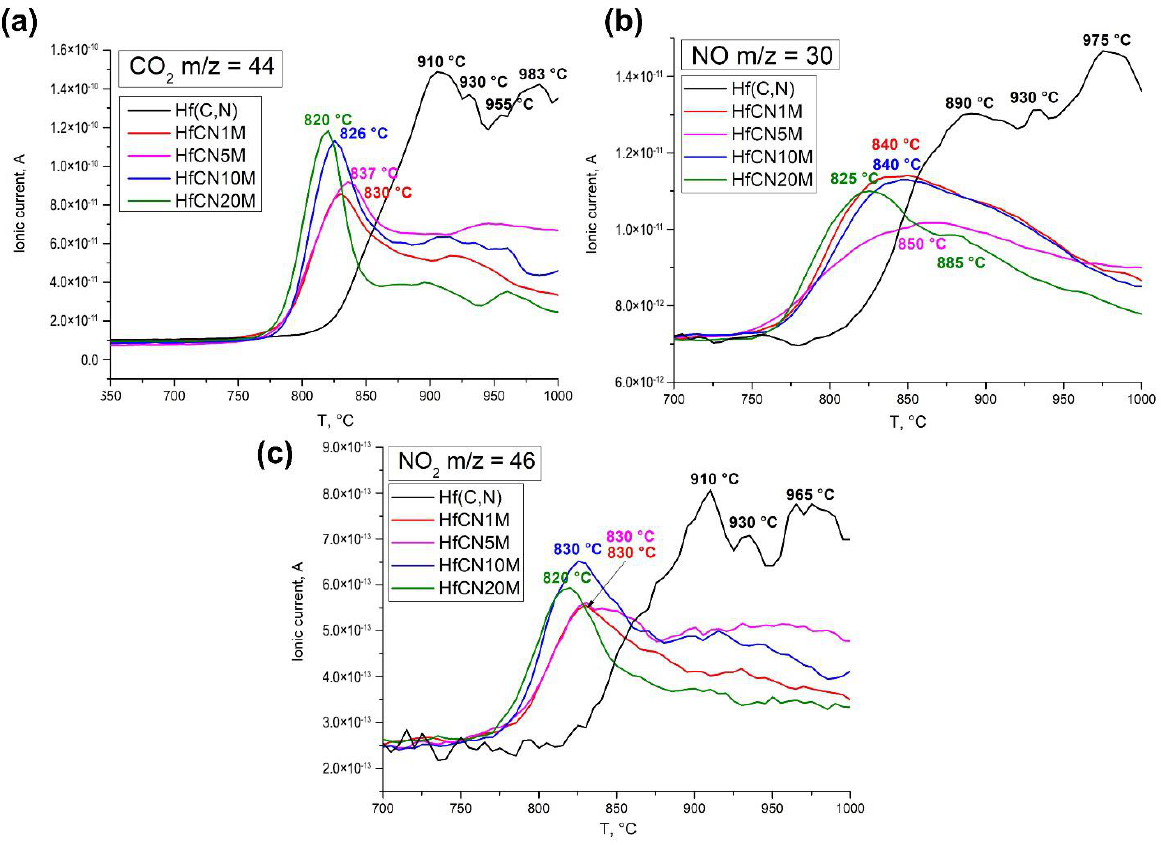
Figure 5. MS analysis during the oxidation of bulk Hf(C,N) and Hf(C,N)-MoSi 2 upon heating to 1000 °C. ( а ) CO 2 , ( b ) NO, ( c ) NO 2.